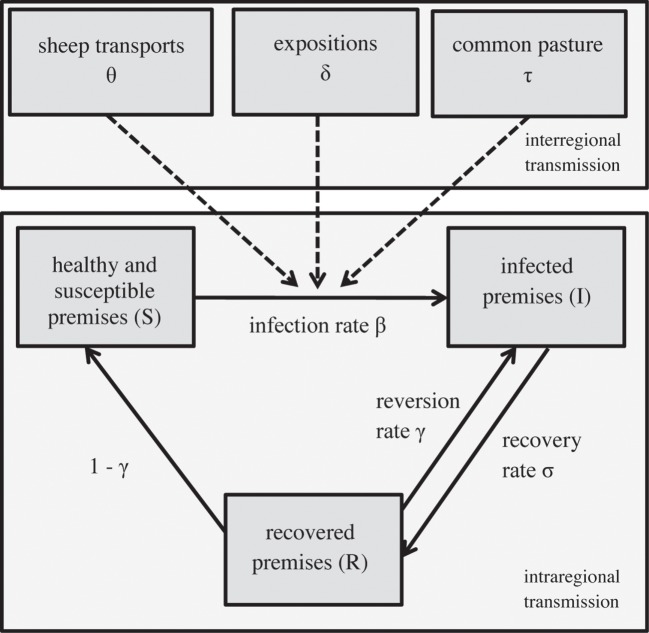
Structure of the epidemiological model simulating within and between the regional spread of footrot, modified from (29).